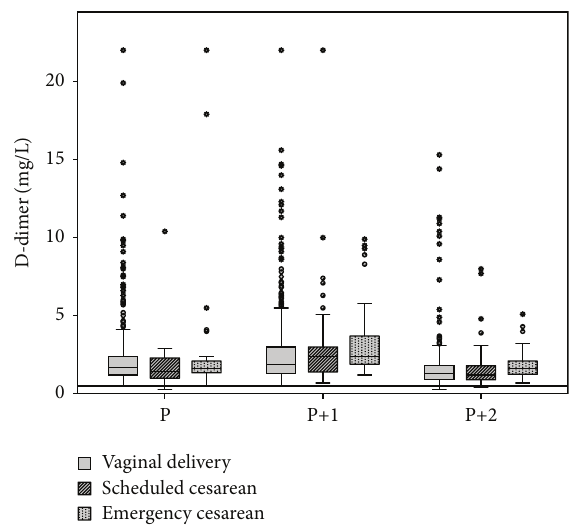
Figure3:D-dimerduringdeliveryandtheearlypostpartum period. The box plots represent the central distribution of D-dimer con- centration (25th–75th percentile), while the horizontal bar in the middle of each box plot represents the median value. The “whiskers” represent the range of values, excluding outliers (circles) and extremevalues(asterisks).Theresultsareshownforvaginaldelivery, scheduled cesarean section, or emergency cesarean section during delivery (P) and on the first (P+1) and second (P+2) postpartum days. The horizontal line represents the conventional threshold of 0.5 mg/L (FEU).